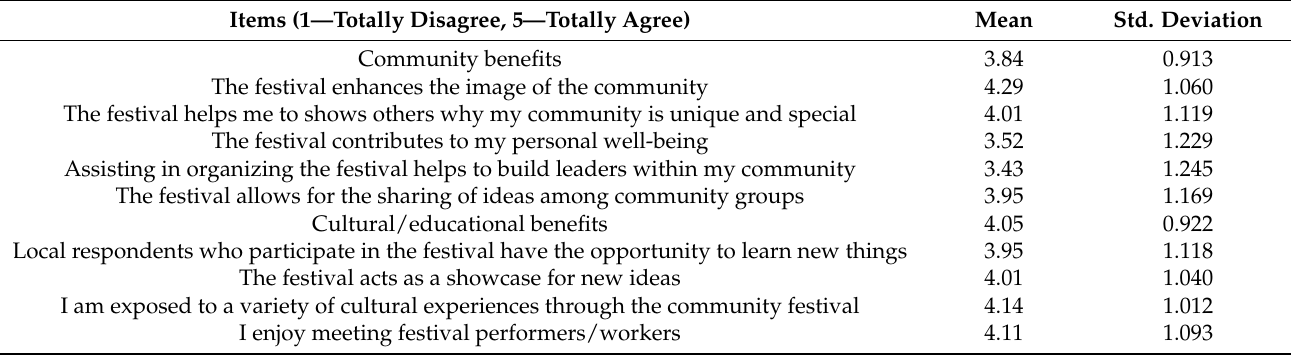
Table 2. Means and standard deviations of the items referring to the festival’s socio-cultural benefits. Items (1—Totally Disagree, 5—Totally